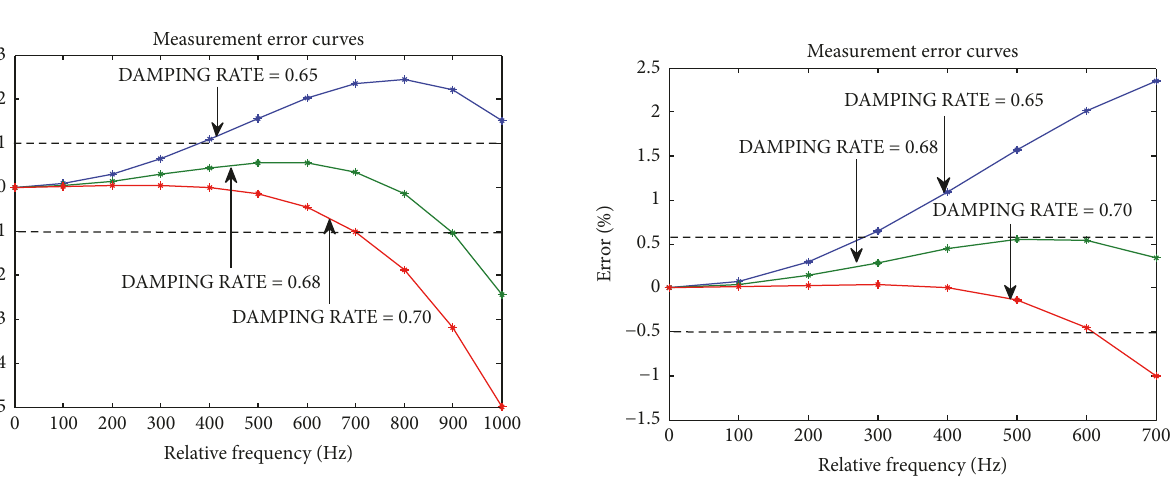
Figure 8: Displacement as a function of relative frequency for three values of damping rate in the case where the relative frequency is varied from 0 to 1500Hz.